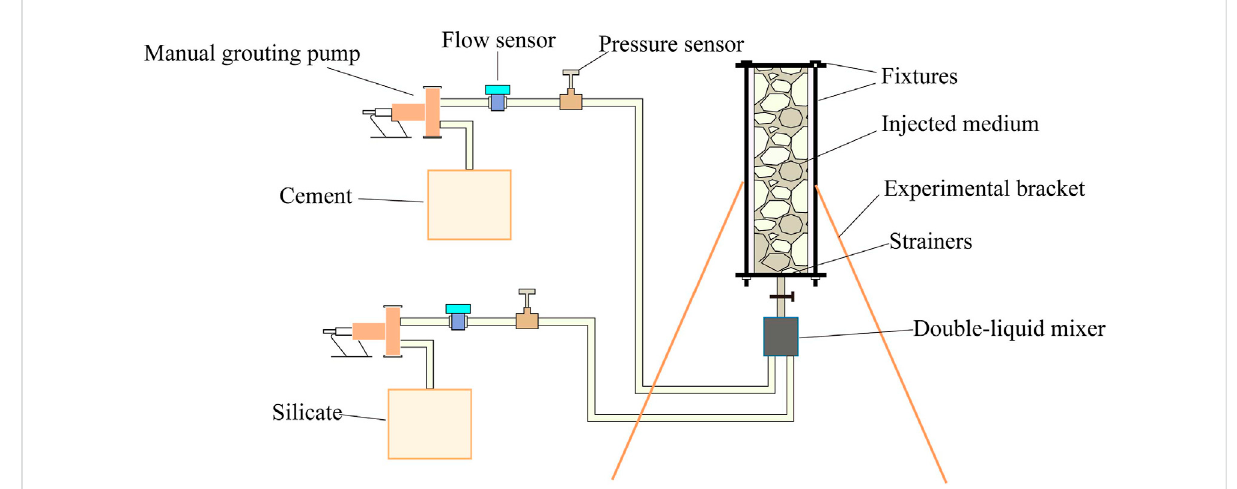
FIGURE 2 Schematic diagram of experiment device.